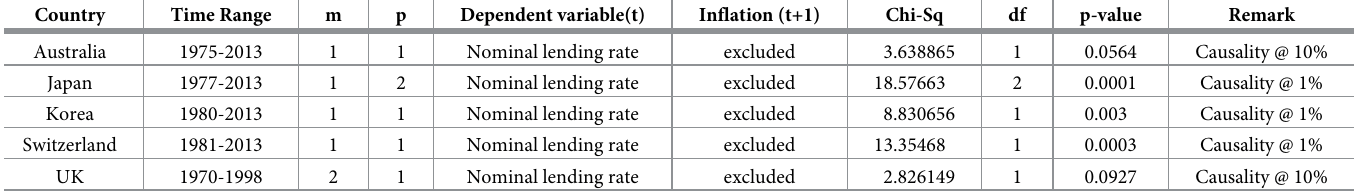
Table 19. VAR Granger Causality/Block Exogeneity Wald Test (Fisherian model).